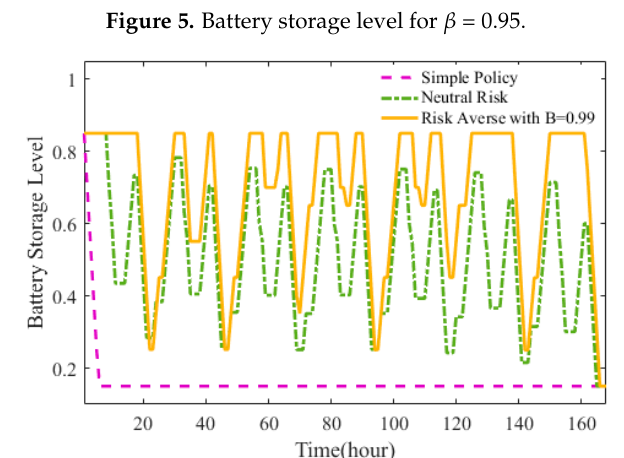
Figure 6. Battery storage level for β = 0.99.